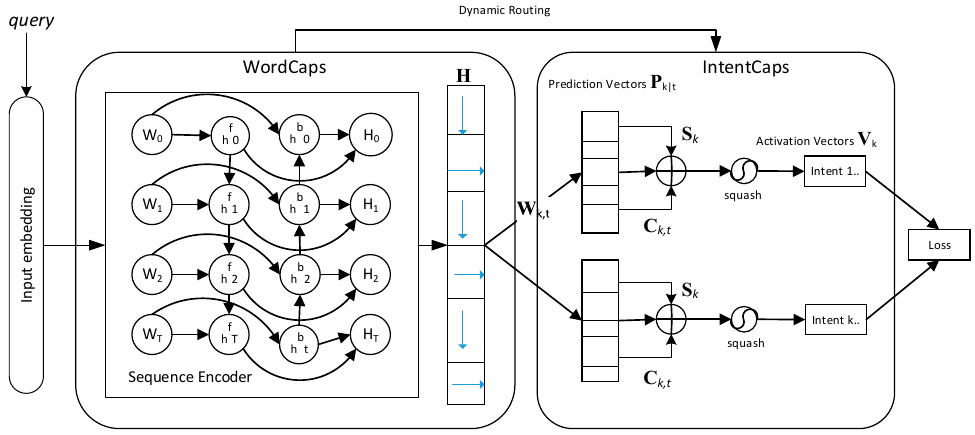
Figure 3. U-IntentCapsNet architecture for intent detection using capsule neural network.